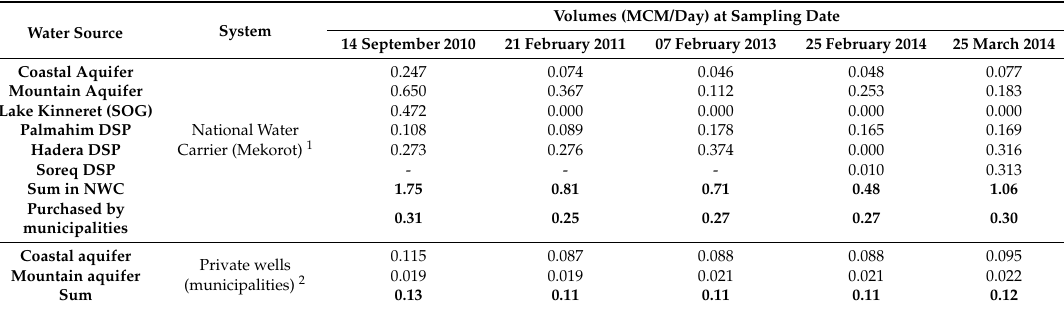
Table 4. Water volumes from the different freshwater sources that were used for the dilution (mixing) calculations.